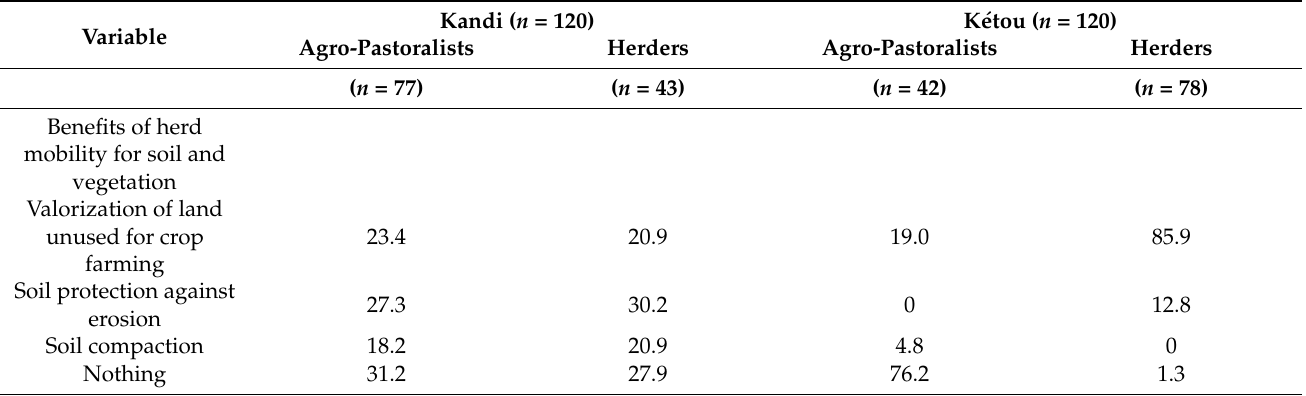
Table 3. Perceptions of different actors of the effects of transhumance on resource use and crop yield in Kandi ( n = 120) and K é tou ( n = 120) in Benin. Values depict percent of responses per